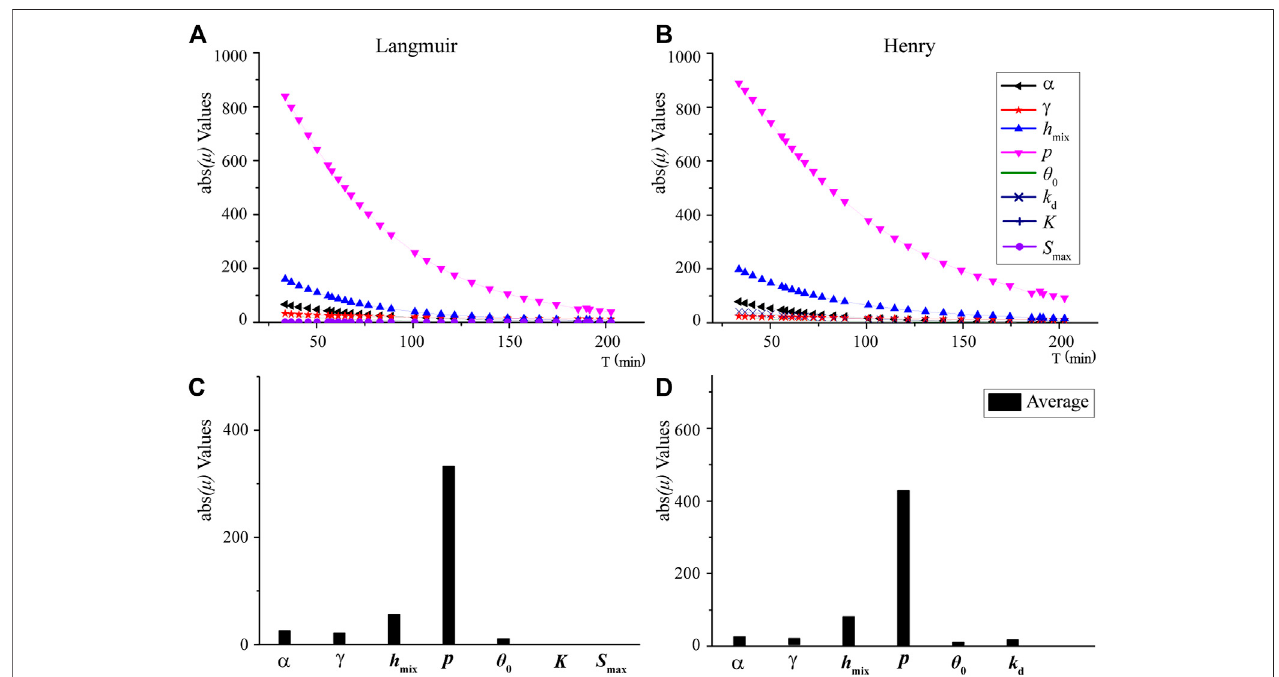
FIGURE 6 | (A) and (B) represent that the absolute mean values of the element effect of each parameter abs( μ ) are changing with time in the model with Langmuir and Henry equations; (C) and (D) is the average of elemental effects at different times for each parameter.